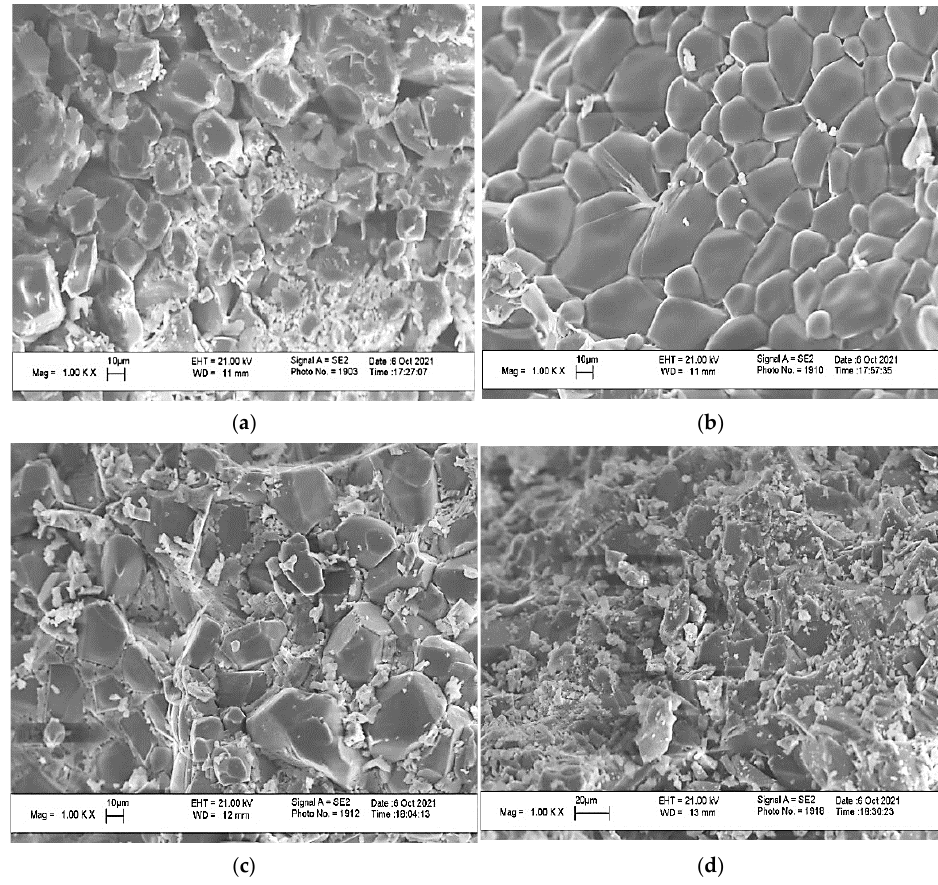
Figure 8. The SEM images of the ceramic materials with a weight ratio of: ( a ) Ca(PO 3 ) 2 /Ca 2 P 2 O 7 = 0/100; ( b ) Ca(PO 3 ) 2 /Ca 2 P 2 O 7 = 5/95; ( c ) Ca(PO 3 ) 2 /Ca 2 P 2 O 7 = 10/90; ( d ) Ca(PO 3 ) 2 /Ca 2 P 2 O 7 = 20/80 at a temperature of 1000 °C.